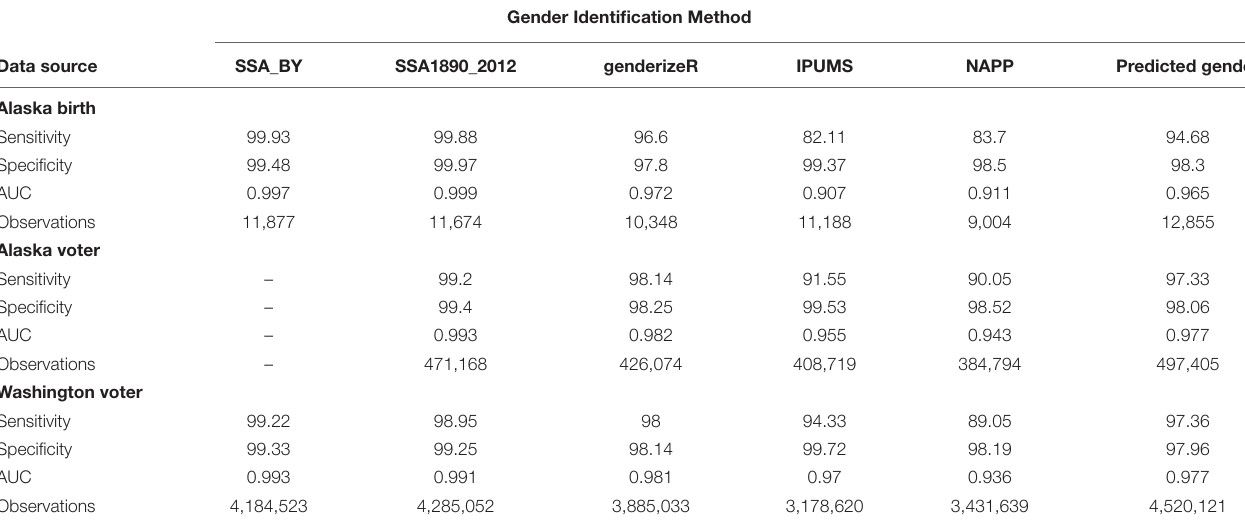
TABLE 2 | Accuracy metrics for gender identification methods and the overall predicted gender, including sensitivity and specificity (accuracy of identifying females and males, respectively) and the area under the receiver operating characteristic curve